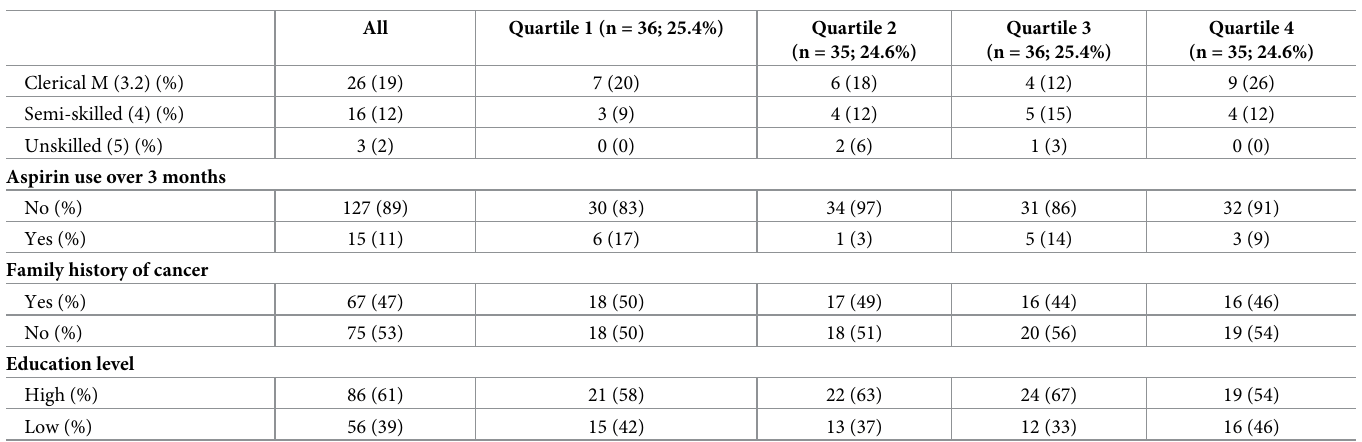
controls in the EPIC-Norfolk study. Fig 6 shows the Spearman’s correlation heatmap of the 31 individual glycans and red meat for cases and controls combined. It attempts to summarize the correlation matrix in a compact visual format. Red meat correlations with each glycan (the top row) are shown as almost white meaning the correlations are close to zero. The remaining rows show the correlation of each glycan with every other. Almost all glycan correlations are positive, appearing as light or dark blue on the diagram. Glycans numbered 2 to 36 are strongly